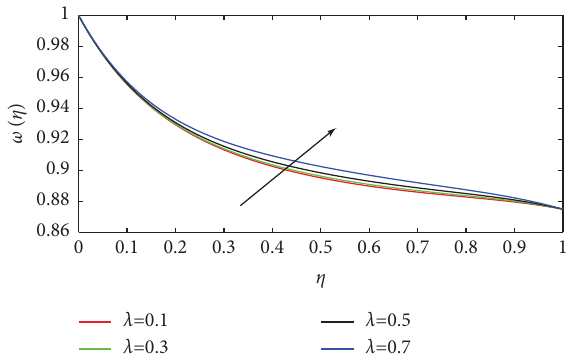
Figure 15: Temperature profles for the diferent values of λ